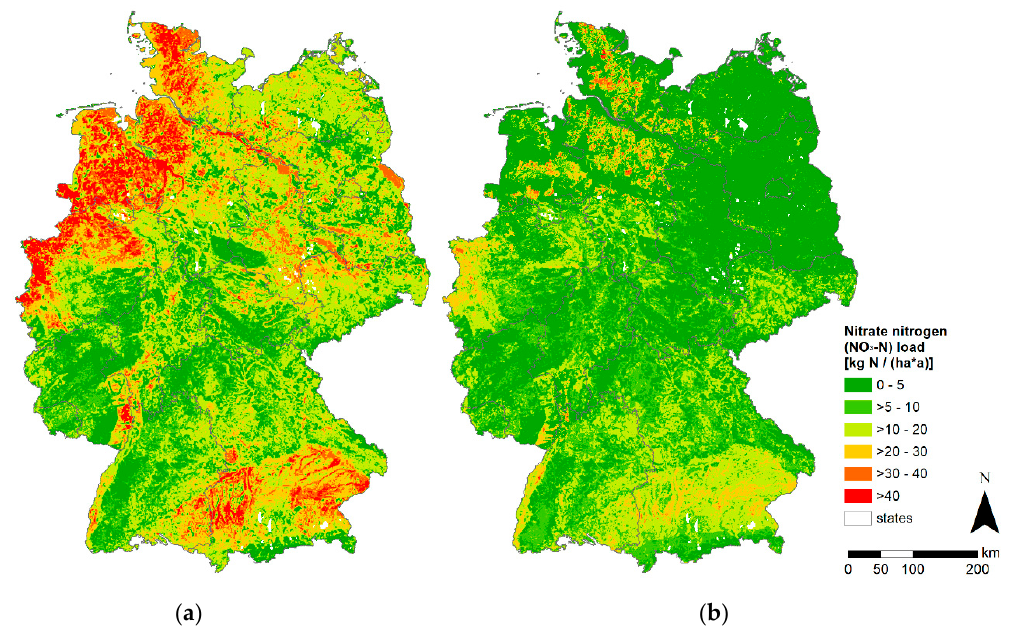
Figure 3. ( a ) Nitrate-nitrogen input load in the groundwater (NO 3 -N_load input_gw ). ( b ) Groundwater nitrate-nitrogen load ( NO 3 -N_load gw ), based on a 1 km × 1 km grid map of Germany (federal state borders: © GeoBasis-DE/BKG, 2017).